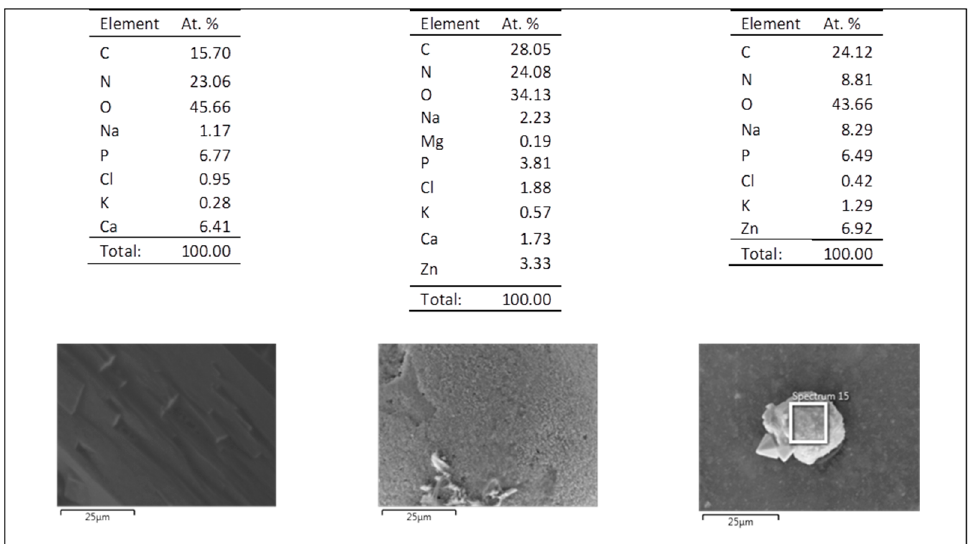
Figure 19. FESEM of ZnO@PLA sample after 21 days in artificial urine.